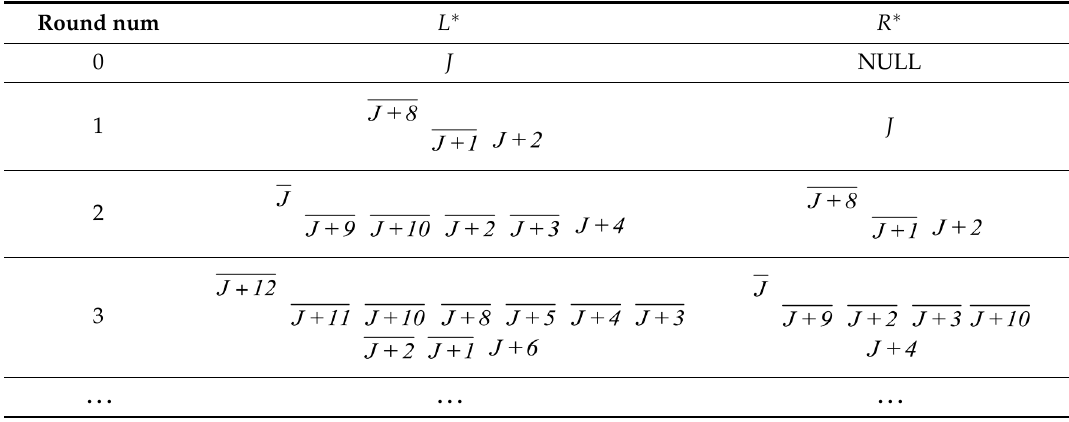
Table 2. The influence of the 1-bit fault injected in the J th bit of plaintext.